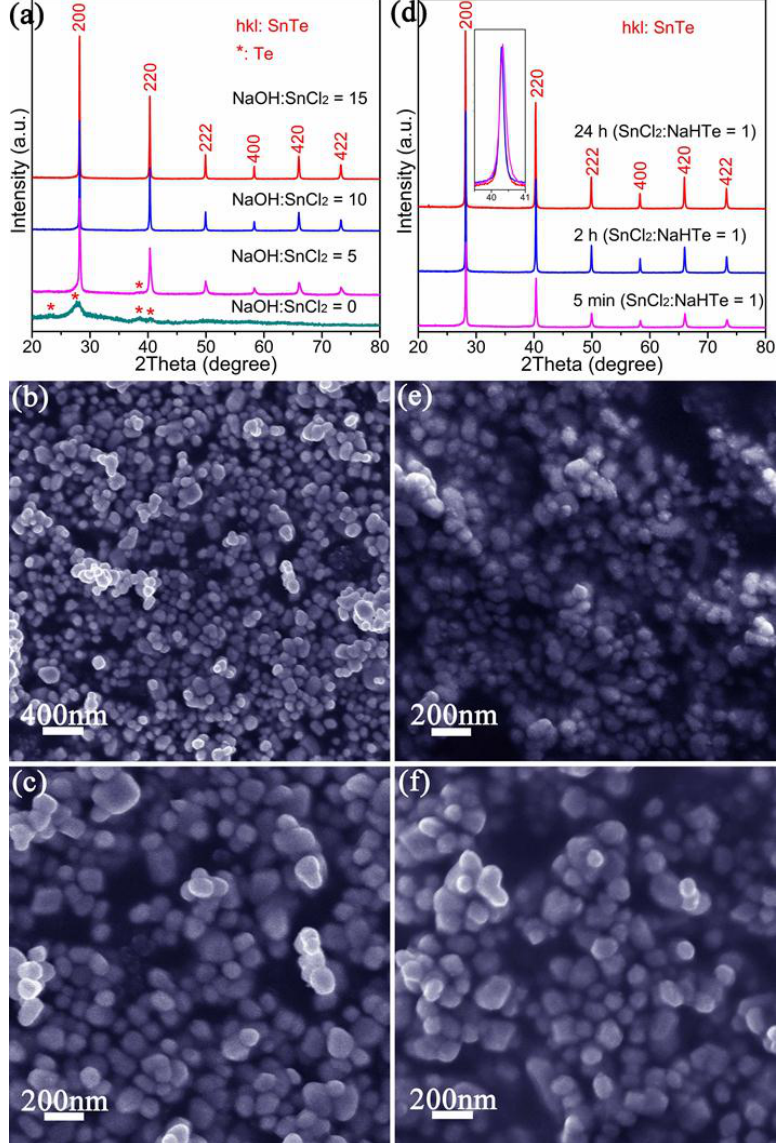
Figure 3. Characterisation of the products synthesised under varied conditions: ( a ) PXD patterns of products synthesised over 2 h with different NaOH:SnCl 2 precursor molar ratios (namely 0:1, 5:1, 10:1, 15:1); ( b , c ) SEM images of the SnTe nanoparticles synthesised over 2 h with a precursor molar ratio of 15:1; ( d ) PXD patterns of 10:1 NaOH:SnCl 2 products synthesised over different reaction durations (namely 5 min, 2 h, 24 h) (the inset shows the (220) peaks in a magnified section of the diffraction pattern); ( e , f ) SEM images of the 10:1 NaOH:SnCl 2 nanoparticles synthesised in 5 min and 24 h, respectively.